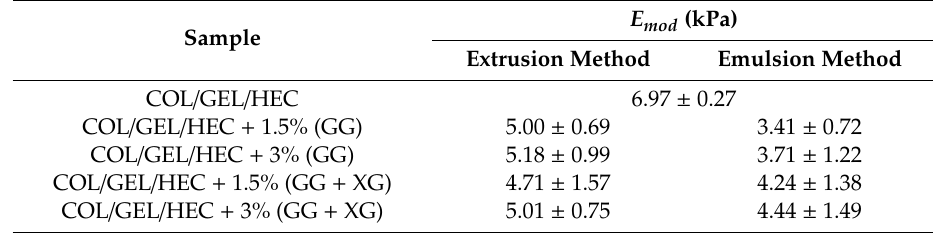
Table 4. Values of compressive modulus (Emod) of COL / GEL / HEC matrices with incorporated microspheres and control sample.